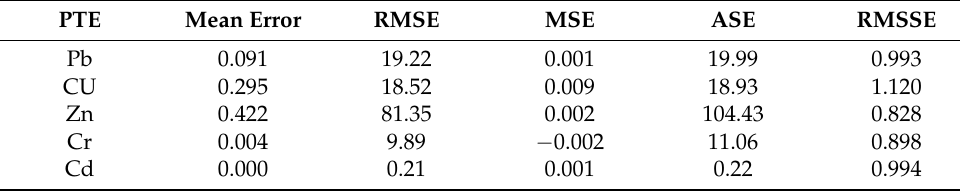
Table 4. Kriging prediction errors of interpolation by the ordinary kriging method. PTE Mean Error RMSE MSE ASE